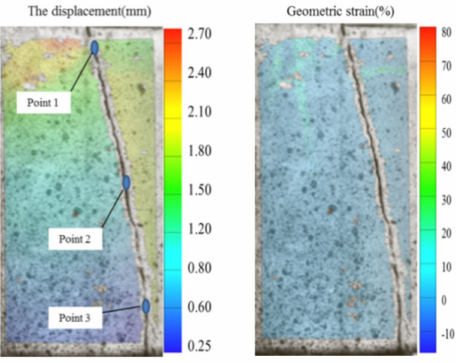
Figure 16. Displacement image and geometric deformation image of the Non-LB